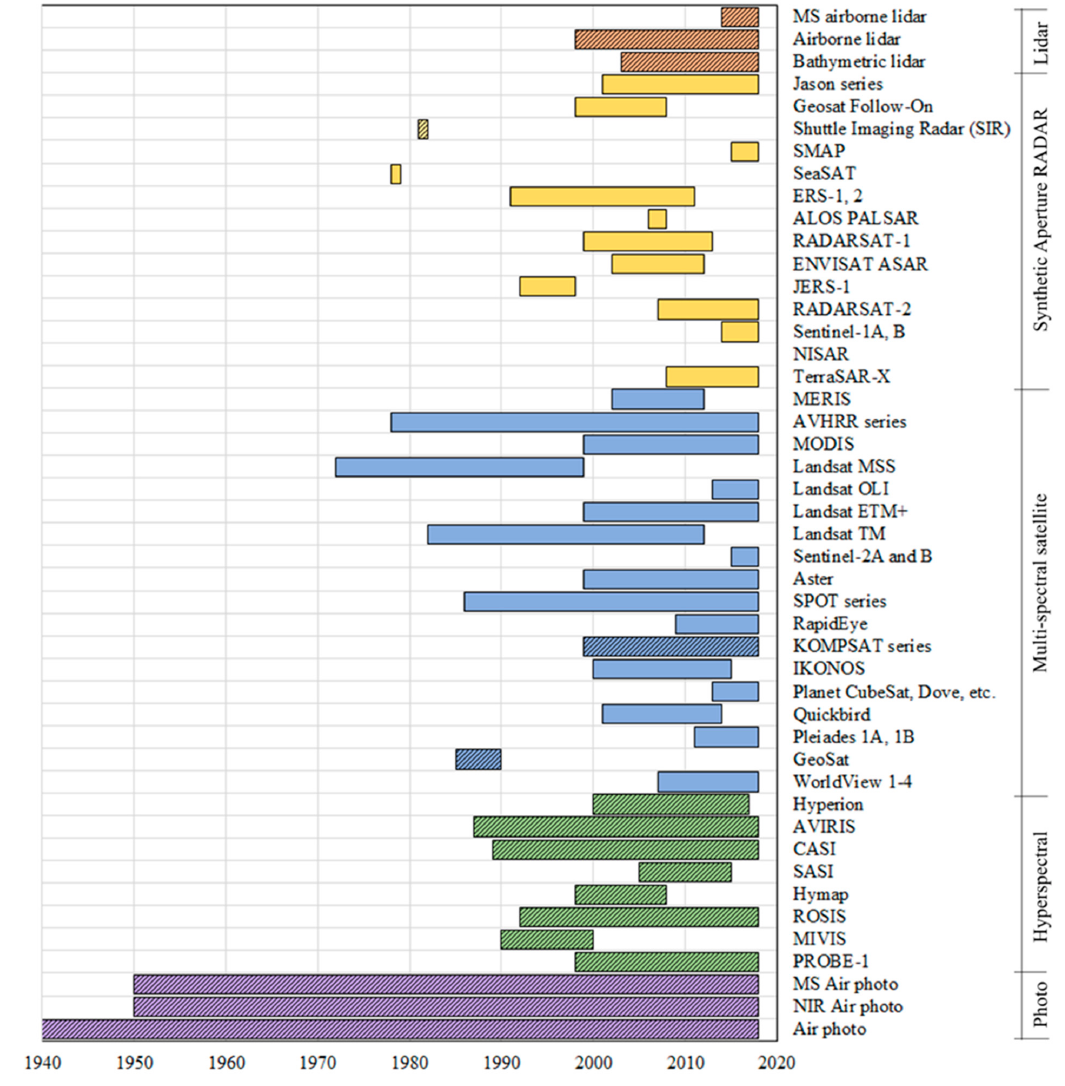
Figure 2. Historic use of airborne and satellite remote sensing systems often used for studying wetlands through time. The year of inception and period of operation of each system and system type (e.g., multi-spectral satellite) is illustrated by different colours, and repeatability of data collection is identified (hatched are planned, single, or planned repeated acquisitions; non-hatched represents repeating data collections). See Part 2 for details on return intervals and pixel resolution. Acronyms include (from top to bottom): Multi-Spectral (MS), Soil Moisture Active Passive (SMAP), European Remote Sensing (ERS), Advanced Land Observation Satellite Phased Array type L-band Synthetic Aperture Radar (ALOS PALSAR), Environmental Satellite Advanced Synthetic Aperture Radar (ENVISAT ASAR), Japanese Earth Resources Satellite (JERS), National Aeronautics and Space Administration-Indian Space Research Organisation (NASA-ISRO) Synthetic Aperture Radar (NISAR), Medium Resolution Imaging Spectrometer (MERIS), Advanced Very High Resolution Radiometer (AVHRR), Moderate resolution Imaging Spectroradiometer (MODIS), Landsat series Multi Spectral Scanner (MSS), Operational Land Imager (OLI), Enhanced Thematic Mapper (ETM + ), Thematic Mapper (TM), Satellite Pour l’Observation de la Terre (SPOT), Korea Multi-Purpose Satellite (KOMPSAT), IKONOS (no acronym, means “Image” in Greek), Airborne Visible InfraRed Imaging Spectrometer (AVIRIS), Compact Airborne Spectrographic Imager (CASI), Shortwave Airborne Spectrographic Imager (SASI), Reflective Optics System Imaging Spectrometer (ROSIS), Multispectral Infrared Visible Imaging Spectrometer (MIVIS), Near Infrared